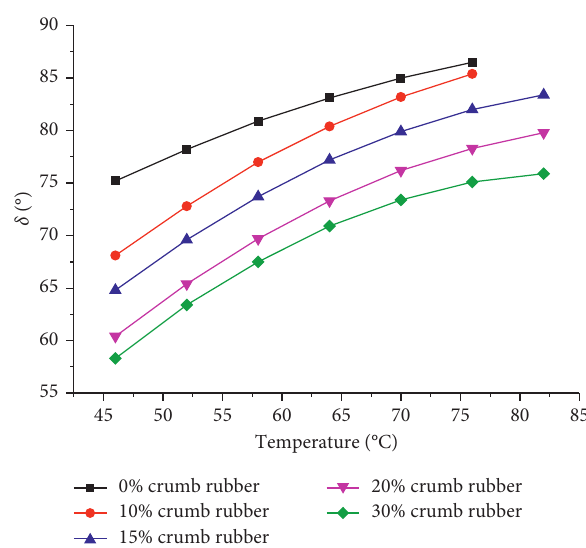
Figure 3: Phase angle δ with different